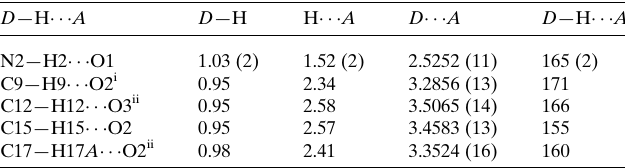
Table 7 Hydrogen-bond geometry (A˚ , (cid:4) ) for (VI).